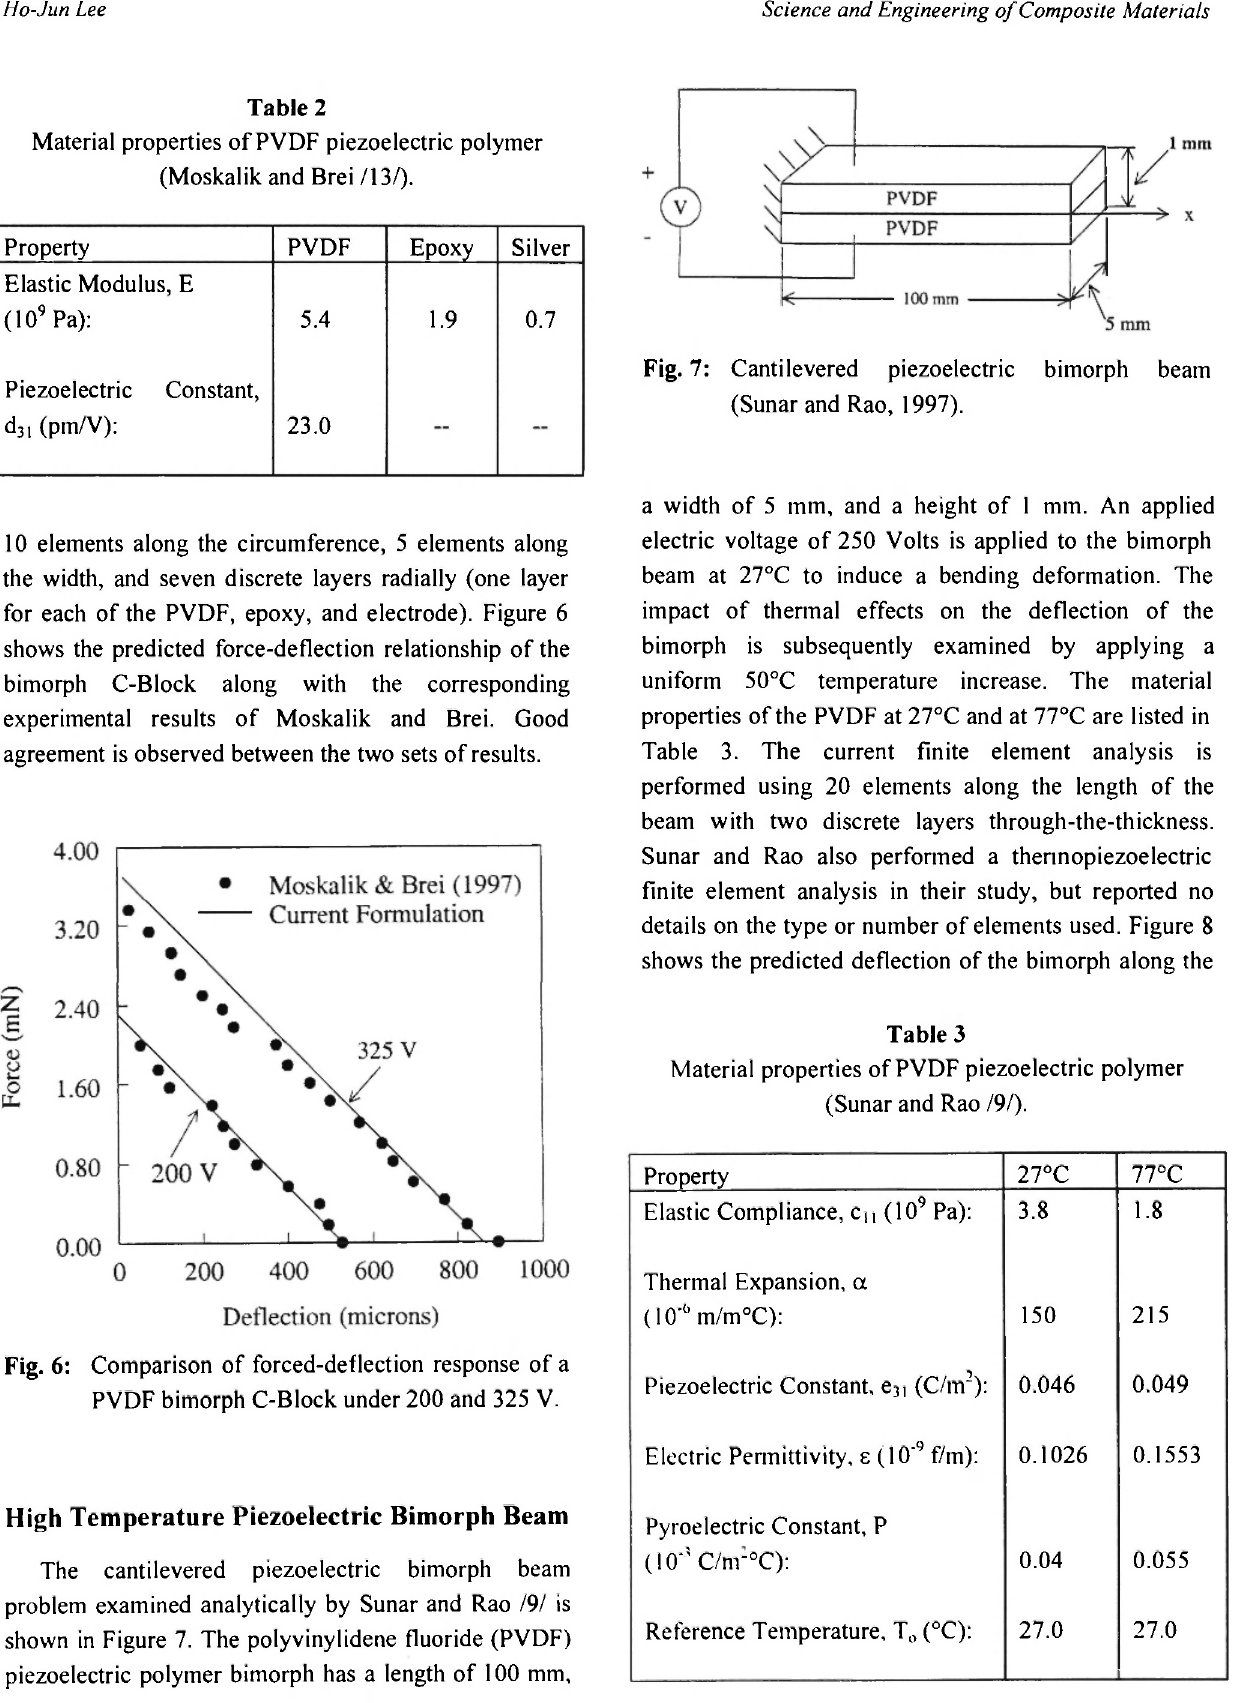
Fig. 6: Comparison of forced-deflection response of a PVDF bimorph C-Block under 200 and 325 V.